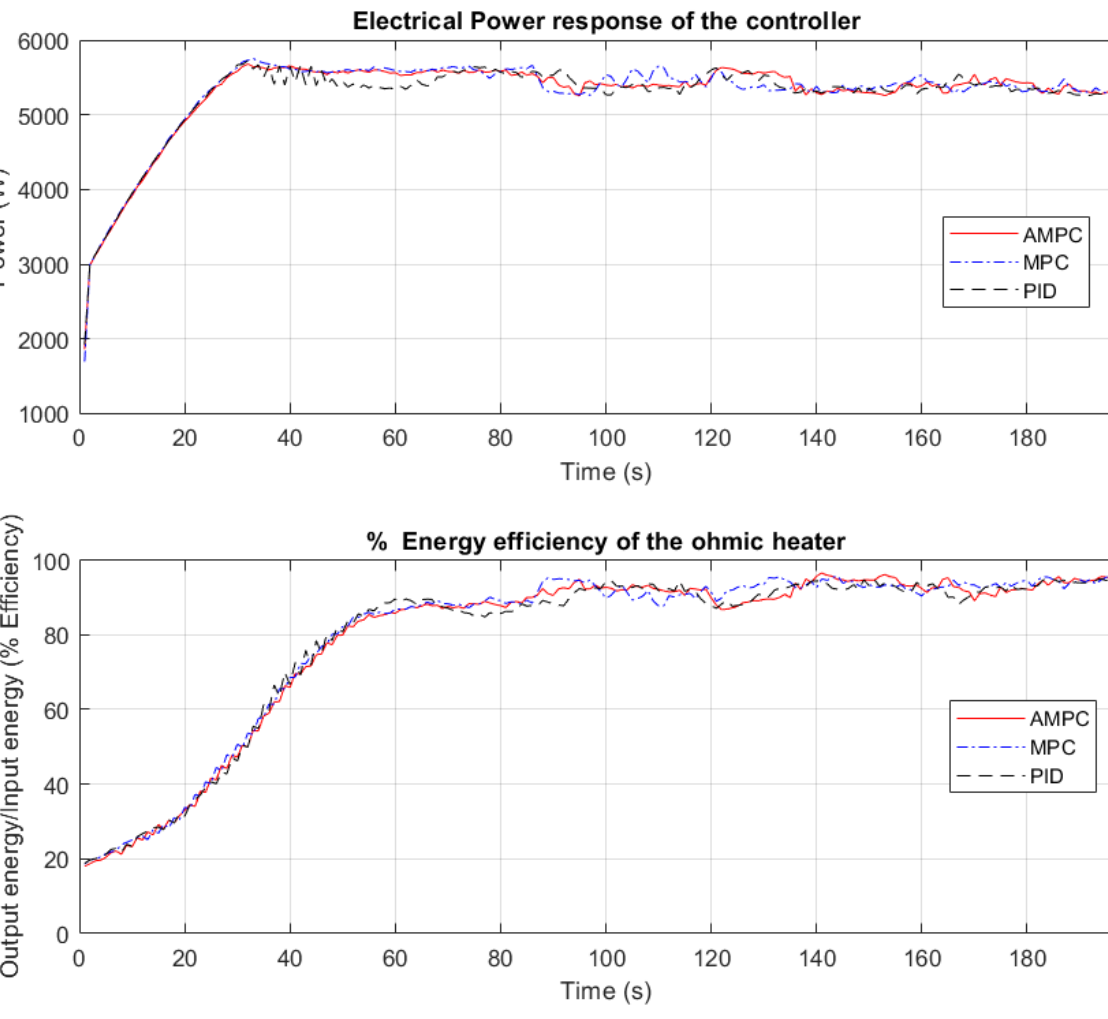
Table 2. Energy consumption and energy efficiency of heated orange juice using PID, MPC, and AMPC